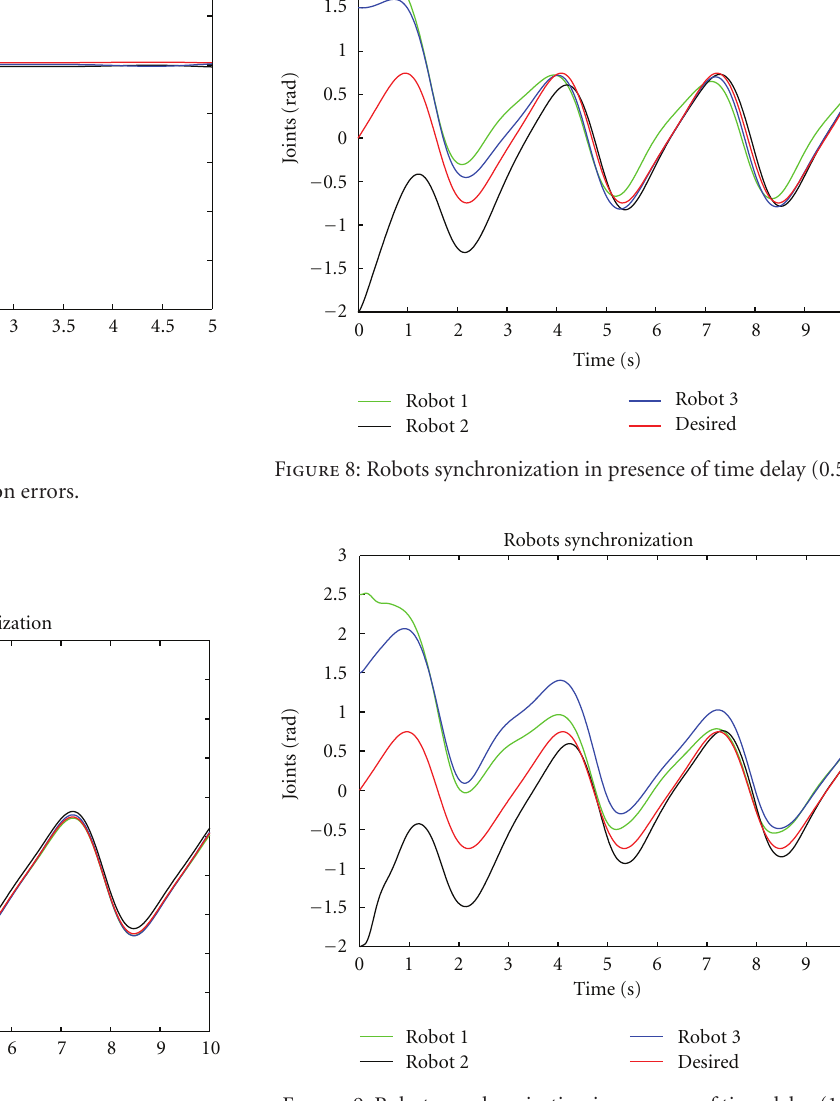
Figure 9: Robots synchronization in presence of time delay